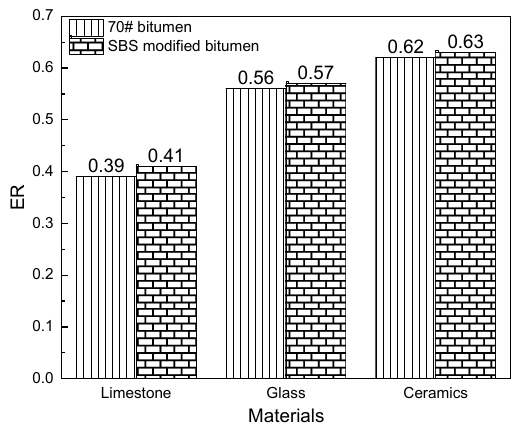
Figure 13. ER value between bitumen and